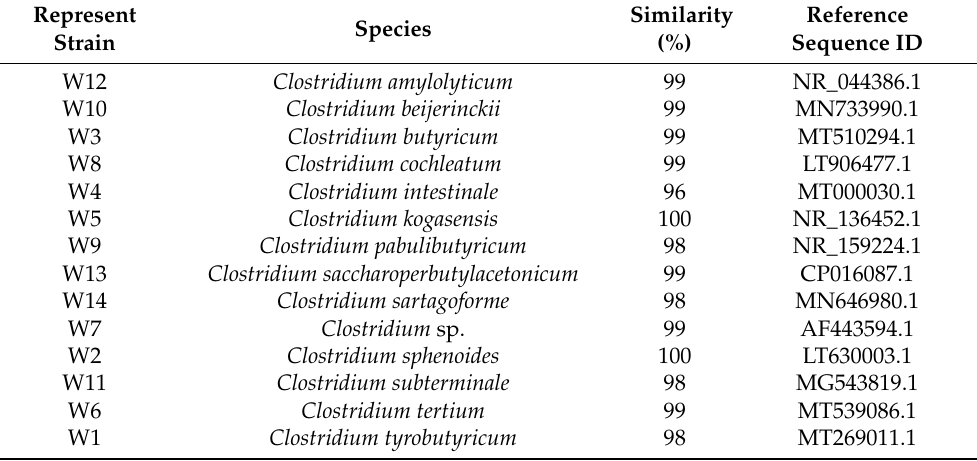
Table A1. Identification of Clostridium strains isolated from strong-flavor Baijiu pit